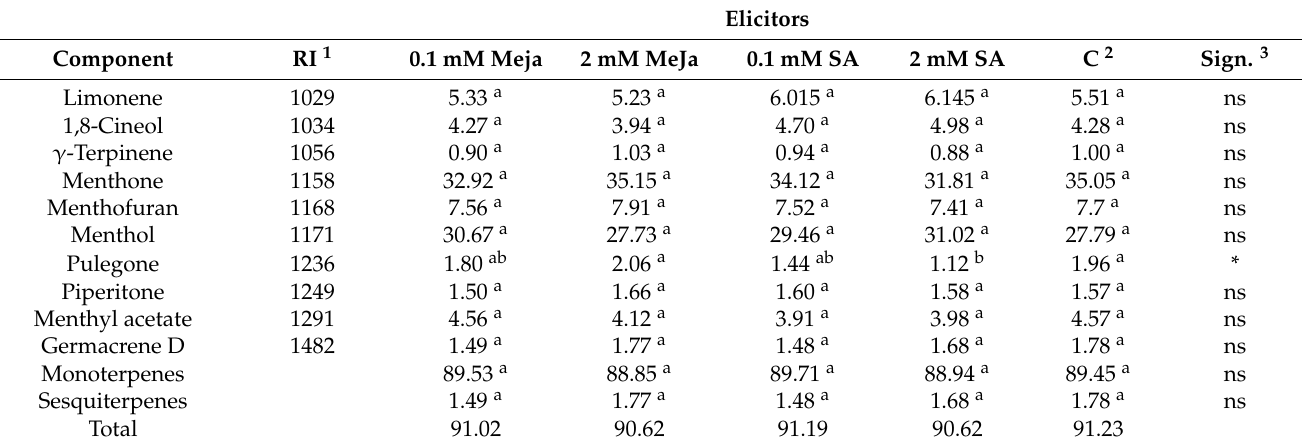
Table 5. The chemical composition of the EO of